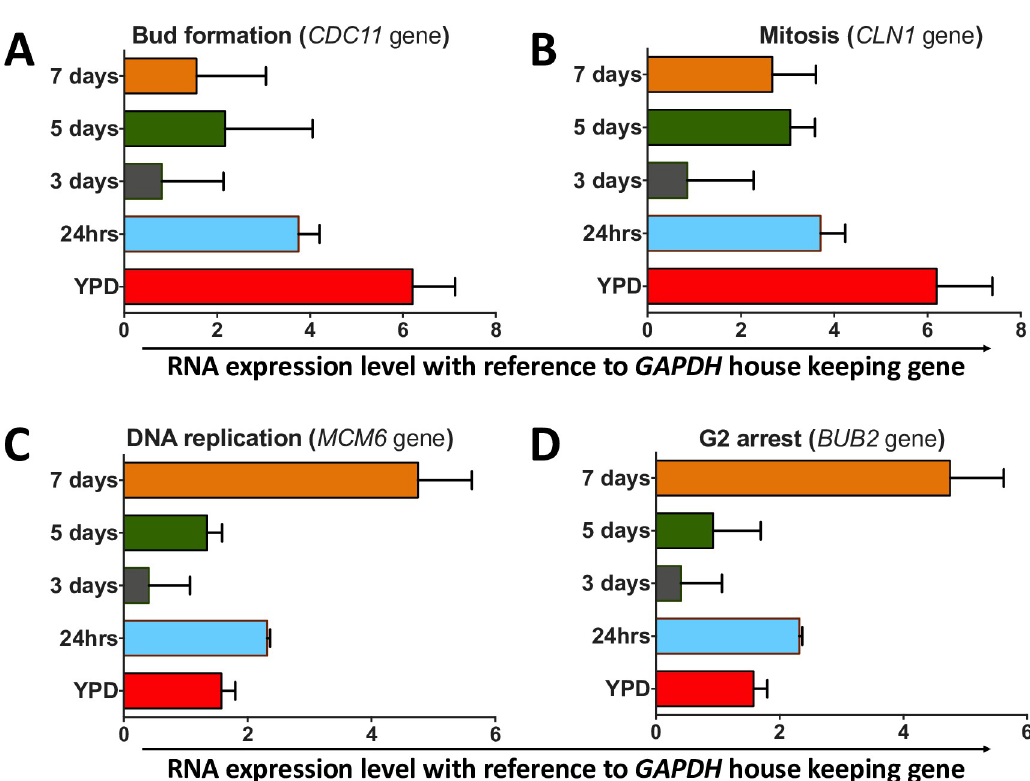
Fig 6. Relative transcription of R265 cell cycle marker genes during titanisation. Quantitative expression analysis of four different cell cycle associated genes in R265 grown in either YPD (control) or titanising conditions for the indicated time points. Expression is shown relative to the housekeeping gene GAPDH. Genes quantified were A) CDC11 ( CNBG_5339) , involved in bud formation; B) CLN1 (CNBG_4803) , associated with balancing cell division and DNA replication [18]; C) MCM6 (CNBG_5506 ), involved in DNA replication; and D) BUB2 (CNBG_4446) , involved in G2 arrest. The graphs represent 3 biological repeats (3 technical replicates each), with error bars depicting the standard deviation of delta - delta C T values.